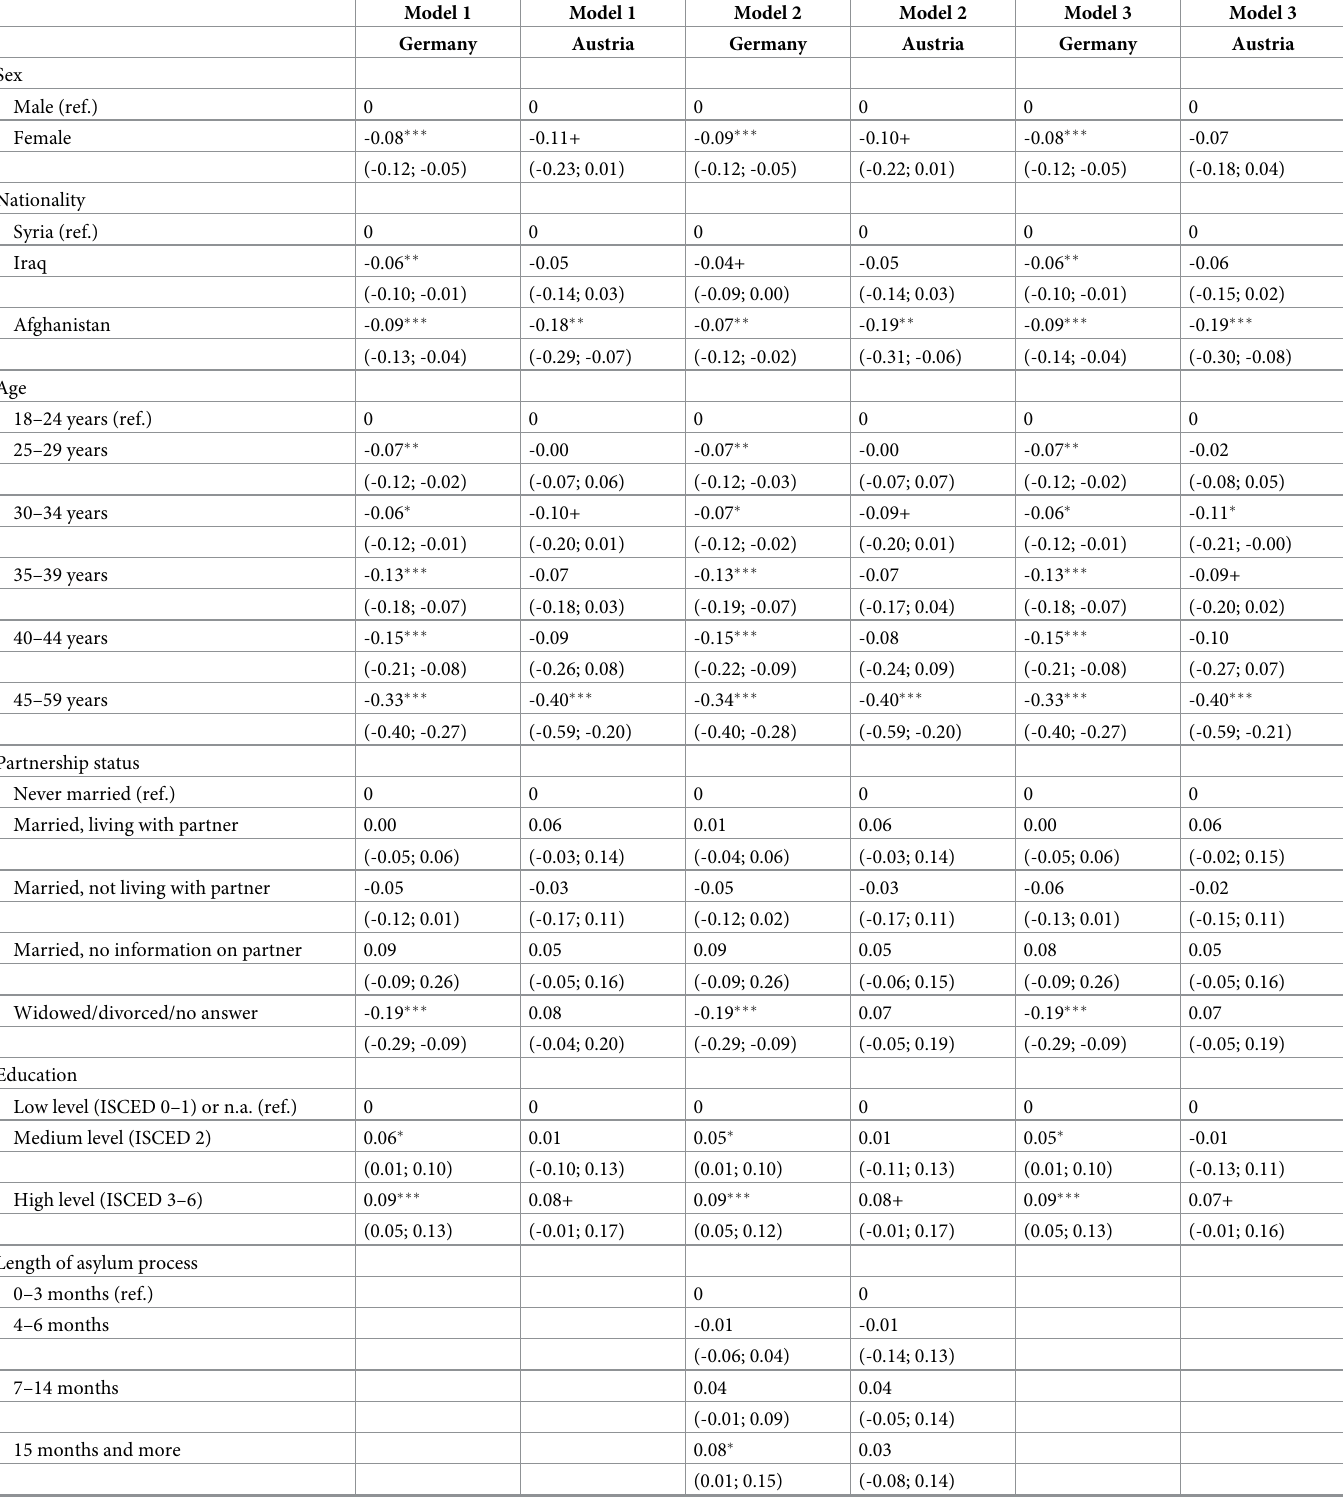
Table 2. Average marginal effects (and 95%CI) for vgSRH, by